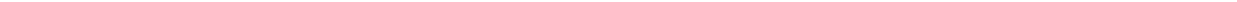
Fig. 2 Transient inhibition of ERK activation blocks regeneration initiation in planarians. a Phosphorylated ERK levels dramatically increased within 15 min post-amputation. b Amputation-induced ERK activation occurred even after depletion of stem cells by γ -irradiation (1 or 2 days post-irradiation (d.p.irr)) and after inhibition of protein synthesis with cycloheximide (CHX). c MEK activates ERK by phosphorylation (pERK); MEK inhibitors PD0325901 (PD) and U0126 (U0) prevent ERK activation by inhibiting MEK. d Treatment with PD and U0 effectively reduced pERK levels. e , f Inhibition of ERK activity severely (PD heads 44/100, trunks 33/100, tails 3/120; U0 heads 43/70, trunks 47/70, tails 11/70) or completely (PD heads 56/100, trunks 67/100, tails 117/ 120; U0 heads 27/70, trunks 23/70, tails 59/70) inhibited formation of blastemas ( e ) and anterior ( notum expression in lower panel) and posterior ( wnt1 expression in upper panel) regeneration poles ( f ). Black arrows: regeneration of new tissues in the blastema; red arrows: remodeling of existing tissues. g , h Other key regenerative responses, such as expression of early wound-induced genes ( g ), as well as stem cell proliferation (pH3, phospho-Histone H3 as a marker for mitotic cells) and accumulation of stem cells and progeny (SMEDWI-1) ( h ) were also severely affected by ERK inhibition. Sample numbers indicated in each image. h.p.a., hours post-amputation; d.p.a., days post-amputation; DMSO was used as the solvent control; scale bars: 200 μ